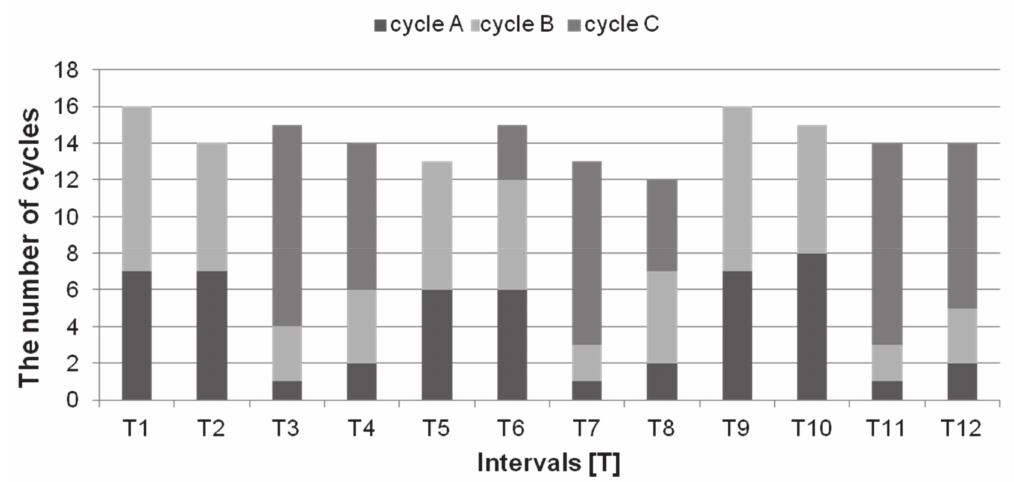
Figure 4. The number of the reticulo-rumen cycles in sheep in the consecutive intervals, including a contribution of cycles A, B, and